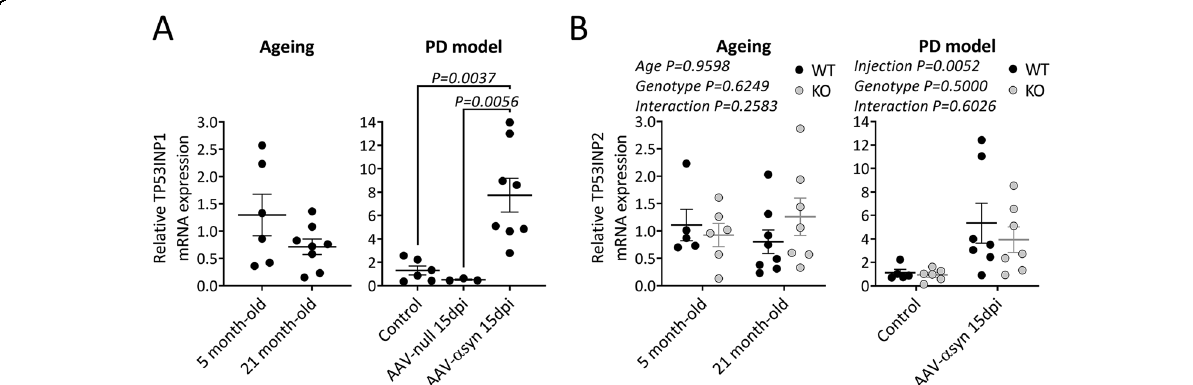
Fig. 3 Nigral expression of Trp53inp1 and Trp53inp2 increases after AAV-mediated α -synuclein overexpression but not in aged mice. A Relative Trp53inp1 mRNA expression, normalized to Hprt housekeeping gene, was measured by RT-qPCR in WT mice at 21 months and at 15 dpi of AAV2-CBA-human- α -synuclein or of AAV null and expressed as fold change versus 5 month-old control mice using the 2 − ΔΔ Ct method. Data are expressed as means ± SEM of n mice per group (ageing study: 6 mice of 5 month-old, 8 mice of 21 month-old; PD model: 6 controls, 8 AAV- α syn and 3 AAV null). Trp53inp1 expression was not signi fi cantly modi fi ed with ageing. It was markedly increased in the SN after the injection of AAV2-CBA- human- α -synuclein both versus control and versus AAV null injection, values from the latter group showing no signi fi cant difference compared to control; one way ANOVA followed by the Holm – Sidak test. B Relative Trp53inp2 mRNA expression, normalized to Hprt housekeeping gene, measured by RT-qPCR in WT and Trp53inp1 − / − (KO) mice at 21 months and at 15 dpi of AAV2-CBA-human- α -synuclein and expressed as fold change versus 5 month-old control mice using the 2 − ΔΔ Ct method. Trp53inp2 expression was not signi fi cantly modi fi ed in aged WT and KO mice. In the PD model, it was signi fi cantly increased with no genotype difference. Data are expressed as means ± SEM of n mice per group (ageing study: 5 WT and 6 KO of 5 month-old, 8 WT and 7 KO of 21 month-old; PD model: control: 5 WT and 6 KO, AAV- α syn: 7 WT and 7 KO). Two-way ANOVA results are indicated above each